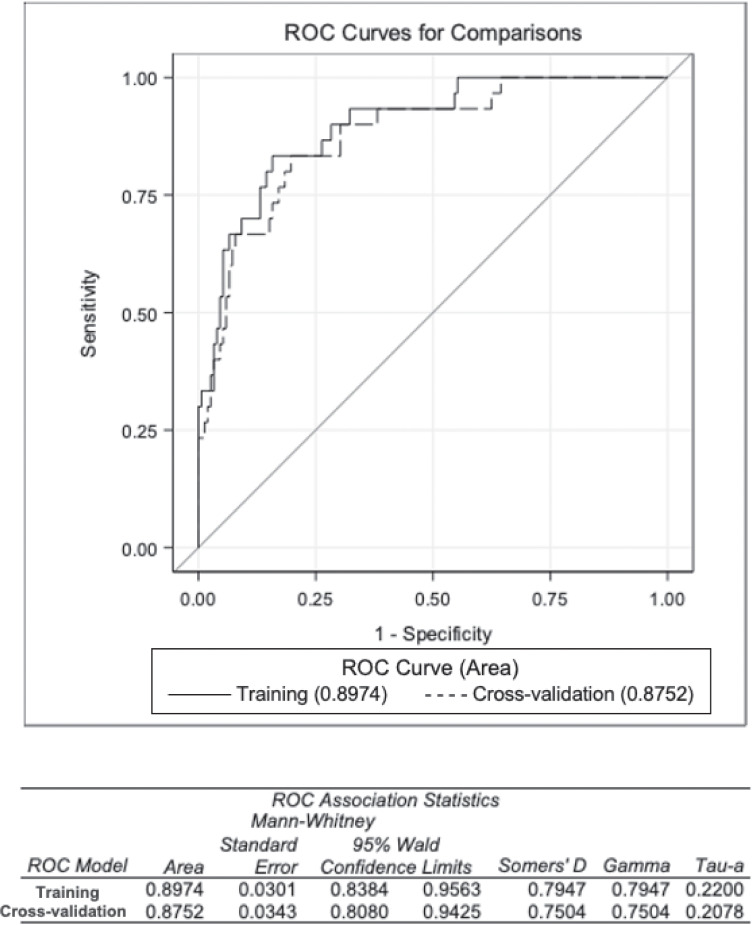
AUC under the ROC analysis—comparison with CV estimate.